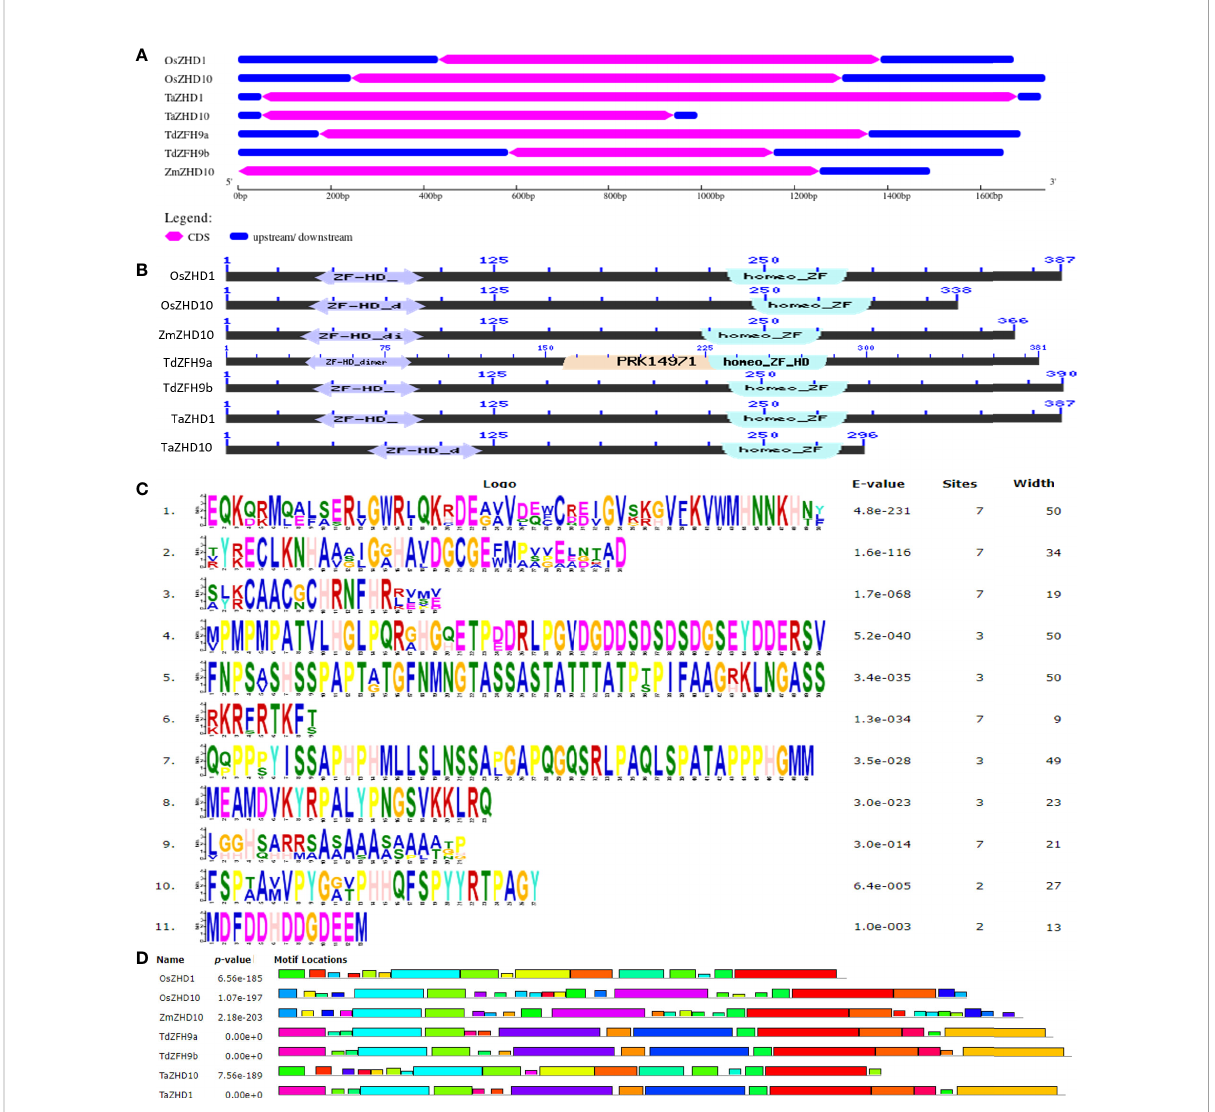
FIGURE 4 Comparative analysis of (A) structural organization of ZHD genes, (B) conserved domains, (C) conserved motifs, and (D) locations of motifs, of candidate leaf rolling ZHD protein of orthologs and their best possible match with